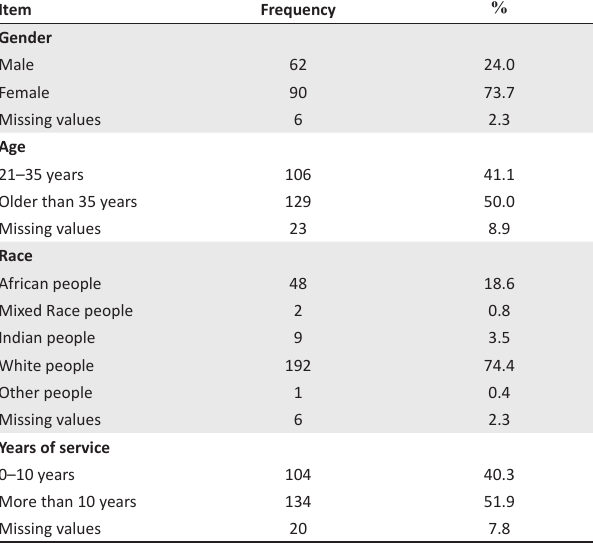
TABLE 1: Characteristics of the participants ( N =